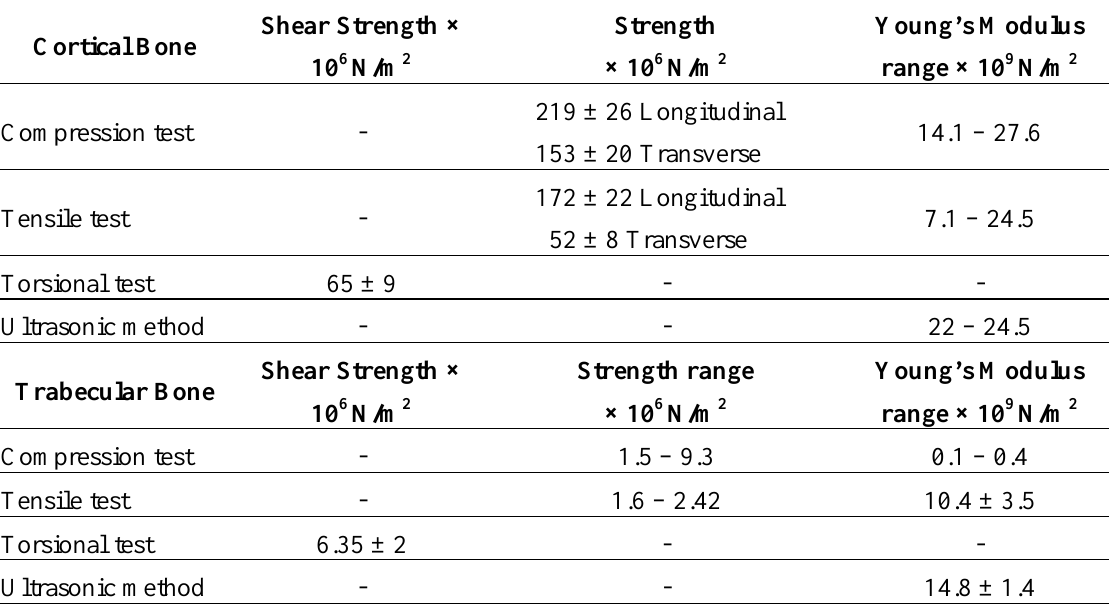
Table 1. Mechanical properties of human cortical and trabecular